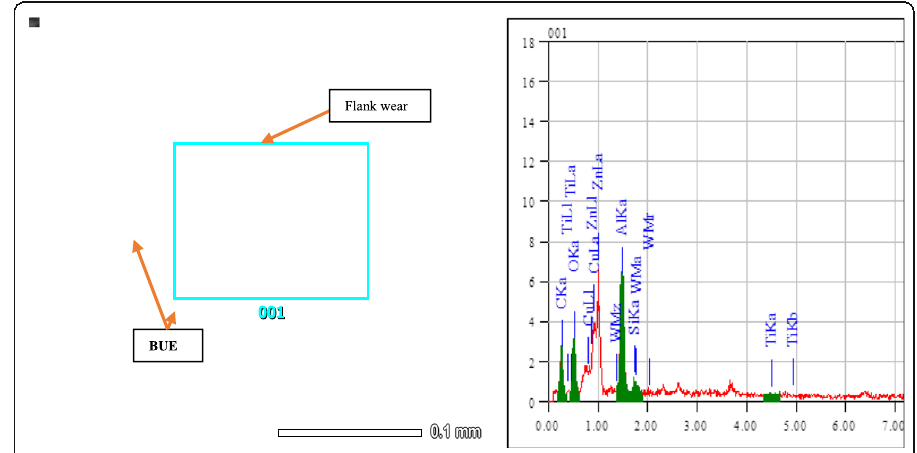
Fig. 10 SEM images of tool A under dry conditions and EDS